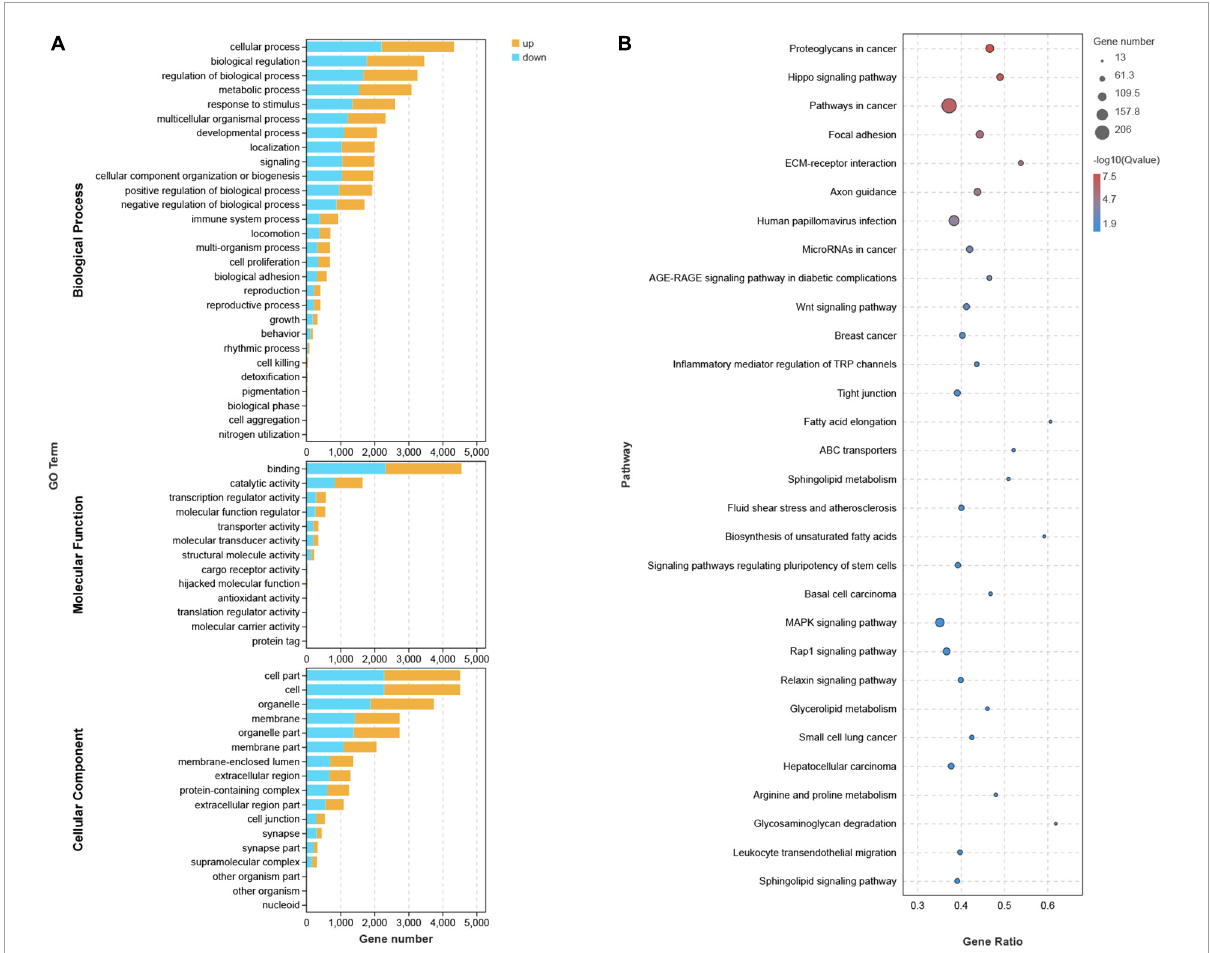
FIGURE4 GO, KEGG Analysis. (A) Each bar in GO analysis represents a pathway, where the up-regulated and down-regulated genes involved in this pathway are indicated in yellow and blue, respectively. (B) In KEGG Pathway analysis, the size of the circle indicates the number of enriched